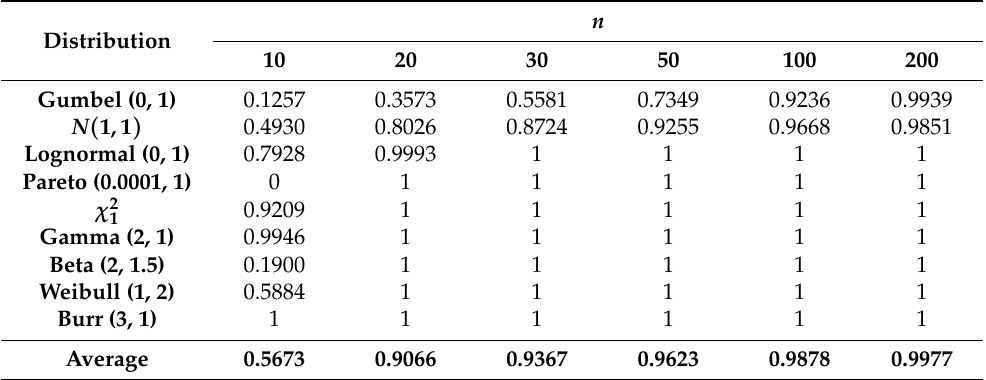
Table 3. Empirical powers of statistic V n for asymmetric alternative distributions for the level of significance α =